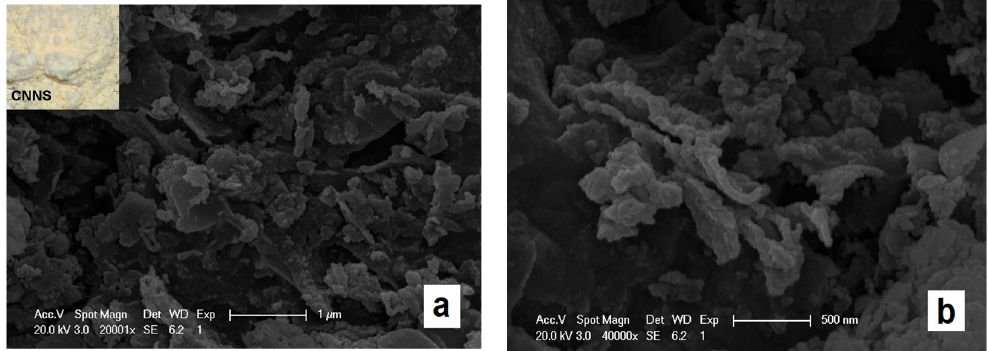
Figure 2. FESEM image and photo of g-C 3 N 4 nanosheets (CNNS).